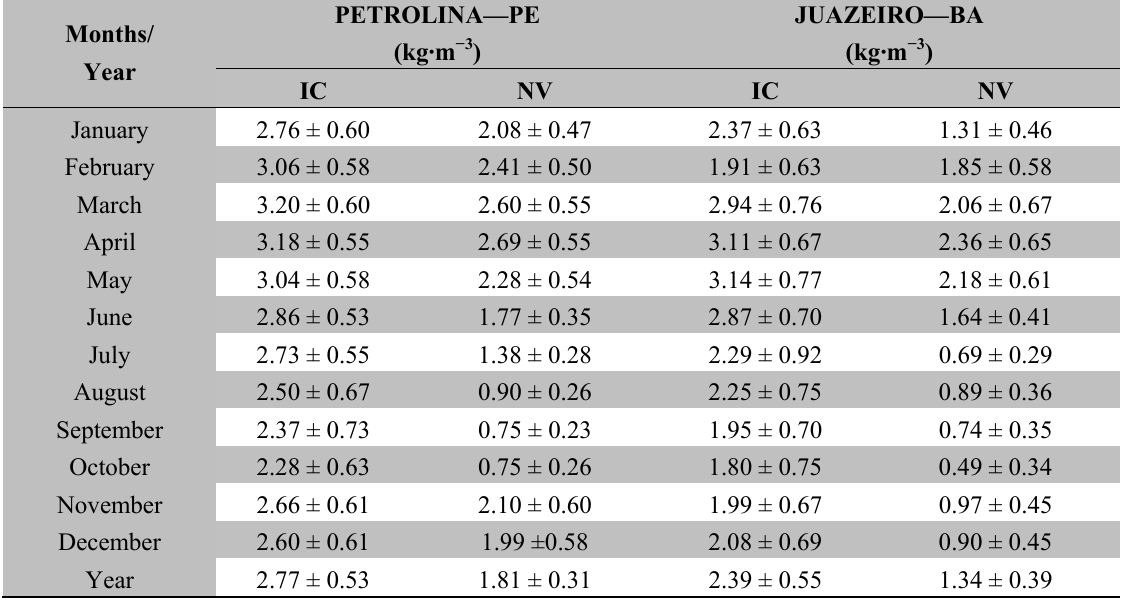
Table 3. Monthly average values and standard deviations (SD) of water productivity (WP) from irrigated crops (IC) and natural vegetation (NV) in Petrolina and Juazeiro municipalities, respectively Pernambuco (PE) and Bahia (BA) states, Brazil, during the year of